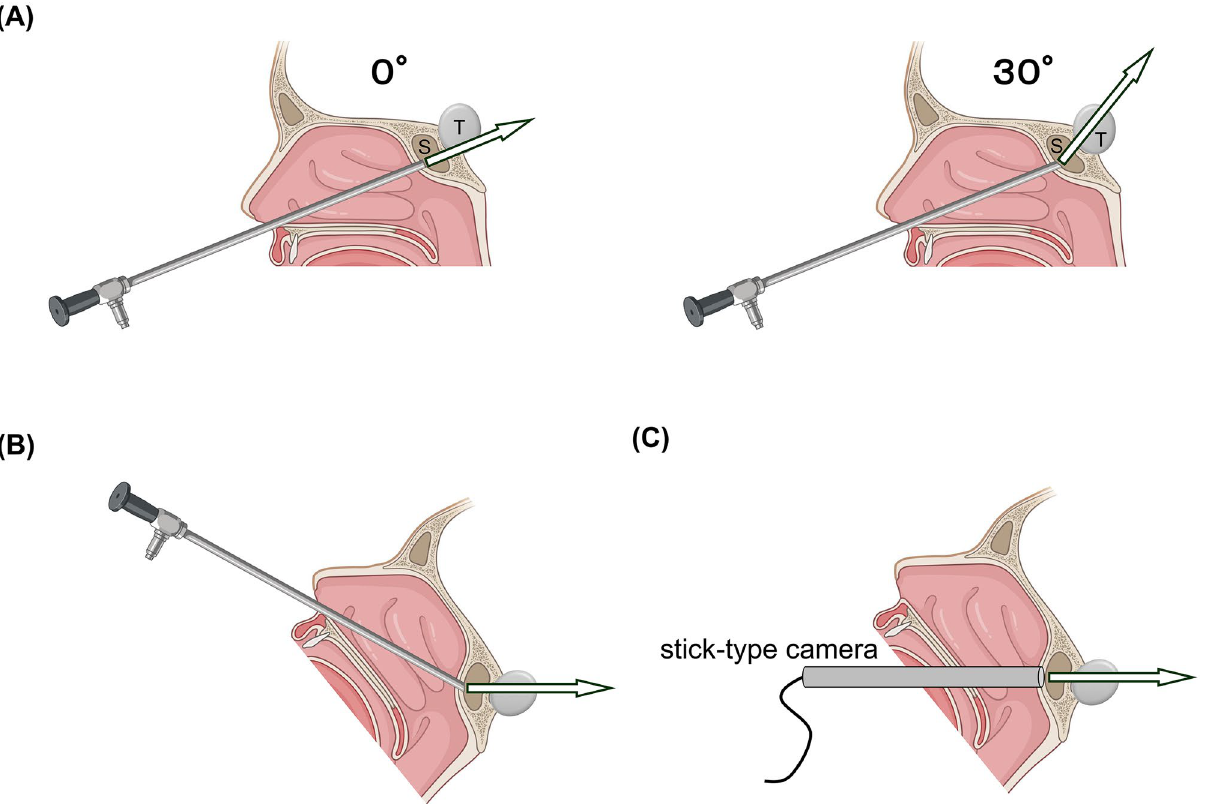
Figure 1. Schematic diagram of the midline sagittal section of the head showing the concept for making a training kit. ( A ) Conceptual diagram using an endoscope used in real surgery. The EndoArm endoscope system with a camera with a 0° field of view for manipulation in the nasal cavity and sphenoid sinus (S), and a camera with a 30° field of view for removal of tumor (T) inside the sella turcica were used. ( B ) Conceptual diagram in position in actual surgery. ( C ) Consideration of placement location of a stick-type camera for training kit. The illustrations were created with